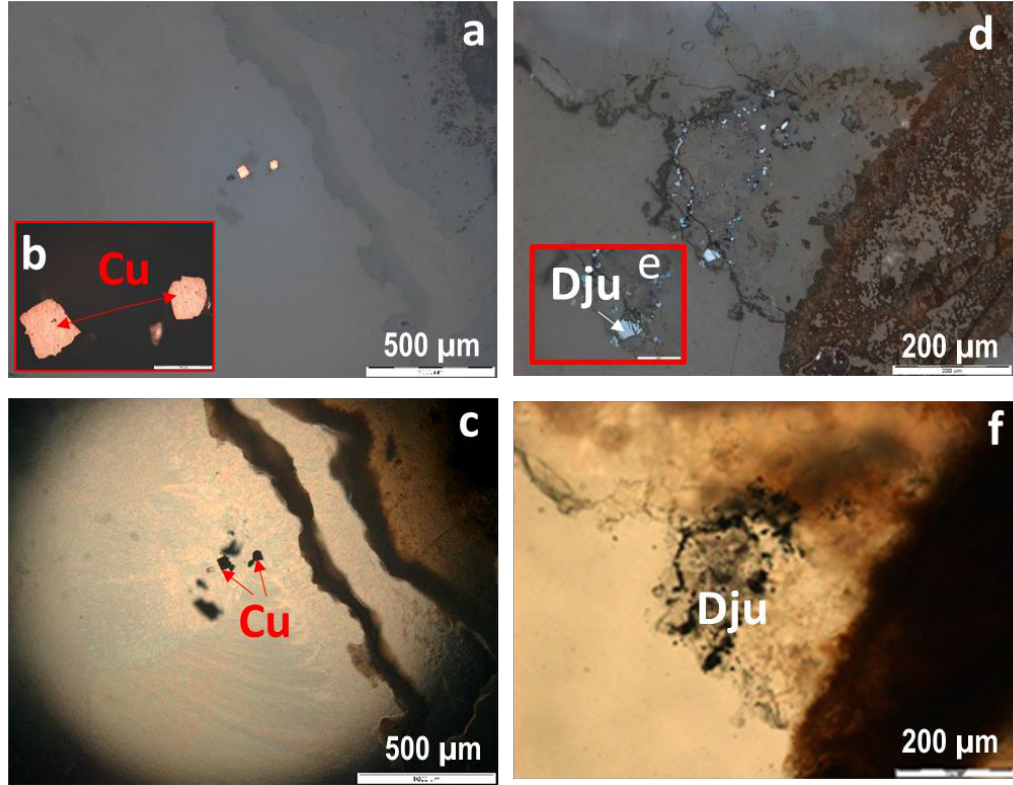
Figure 5. Inclusions of native copper (Cu) ( a – c ) and djurleite (Dju) ( d – f ) surrounded by chalcedony